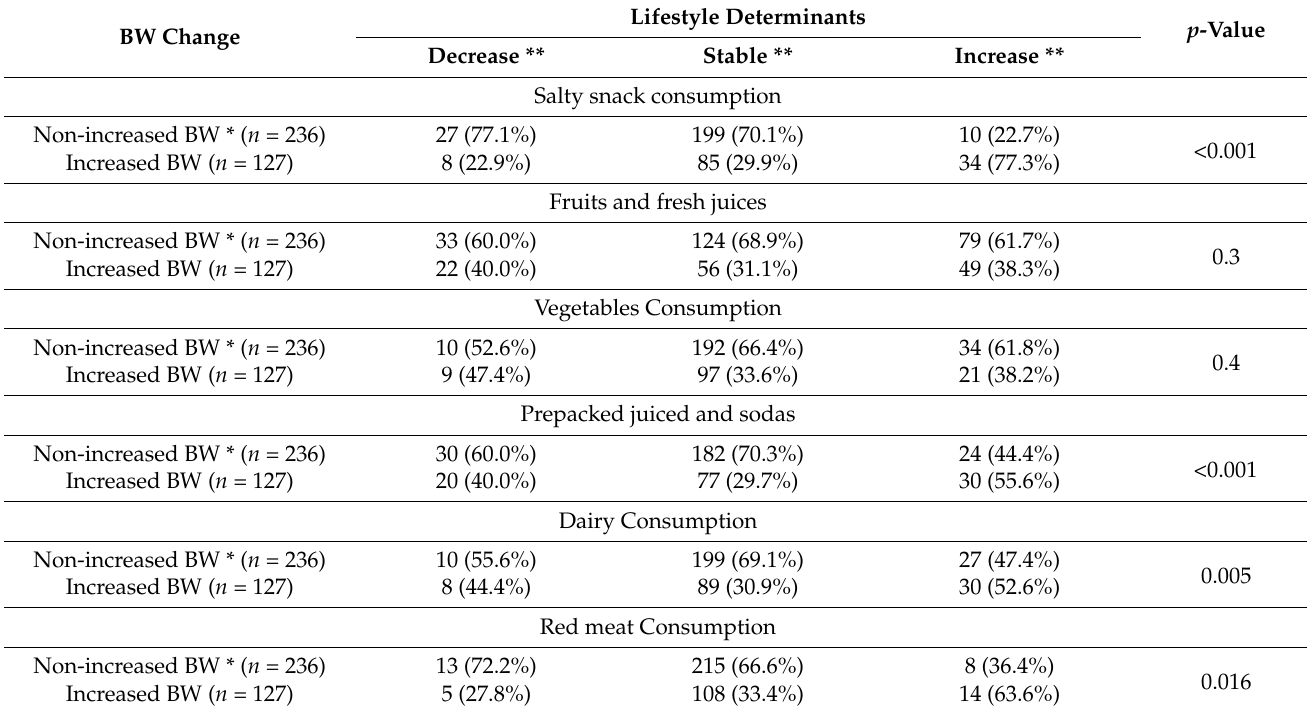
Table 5. Associations between dietary or lifestyle changes and children’s and adolescents’ body weight (BW) changes during the first COVID-19 lockdown in Greece. The COV-EAT